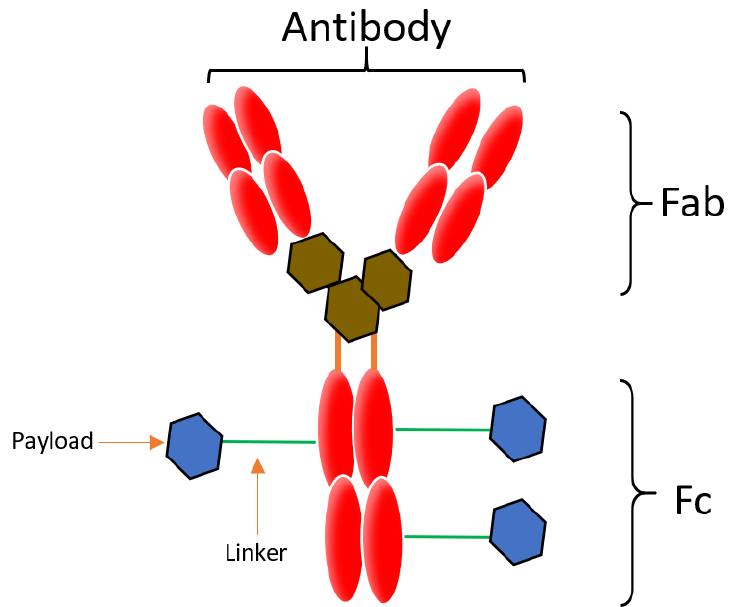
Figure 1. Basic structure of an ADC: An ADC is comprised of the monoclonal antibody (red), linker (green) and payload. The payload can be conjugated to different parts of the mAb and is commonly attached via cysteine (brown) or lysine residues (blue). Generally, more than one payload can be attached. An IgG antibody structure consists of two Fab fragments. Each fragment consists of one heavy chain and one light chain and the Fc fragment.